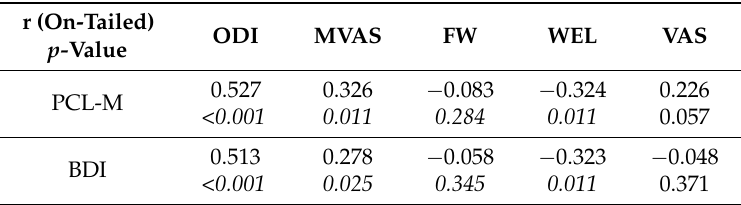
Table 2. Correlation of Posttraumatic stress disorder CheckList-Military (PCL-M) and Beck Depression Inventory (BDI) scores to self-report measures of disability (Oswestry Disability Inventory (ODI), Million Visual Analog Scale (MVAS)) and lifting scores (Floor-to-Waist (FW), Waist-to-Eye Level (WEL)) among FORT completers.